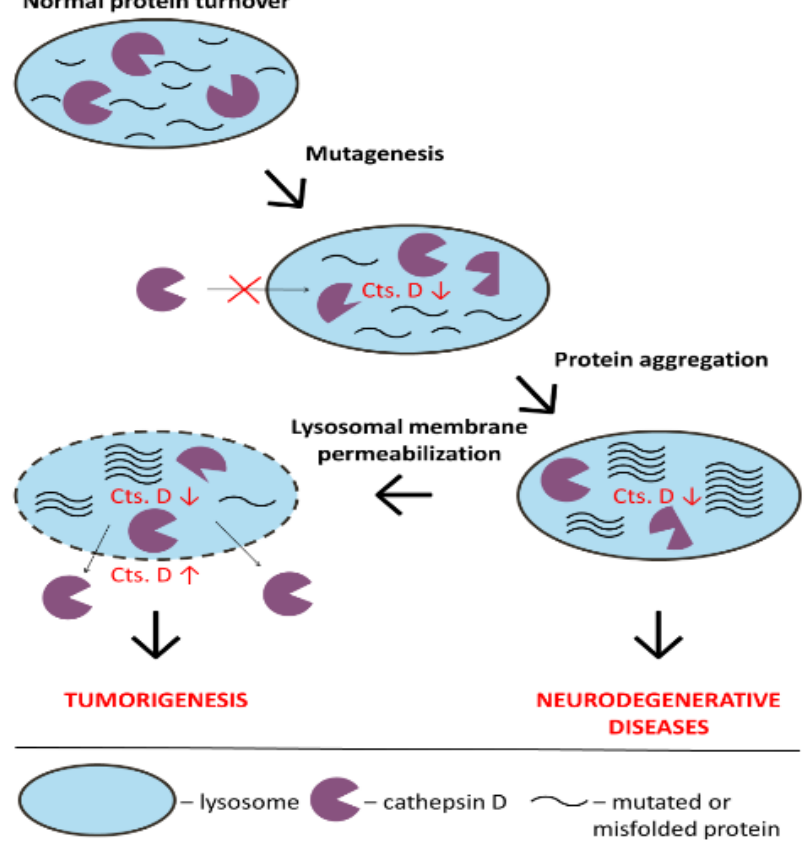
Figure 2. Role of Cathepsin D in cancer and neurological disorders. Cathepsin D mutations may cause a decrease in its lysosomal traffic and activity, leading to protein aggregation in the organelles and neurodegenerative diseases development. Protein aggregation may cause lysosomal membrane permeabilization with the subsequent increase of cathepsin D outside the lysosomes. On the other hand, the excessive extracellular activity of cathepsin D can contribute to tumorigenesis.